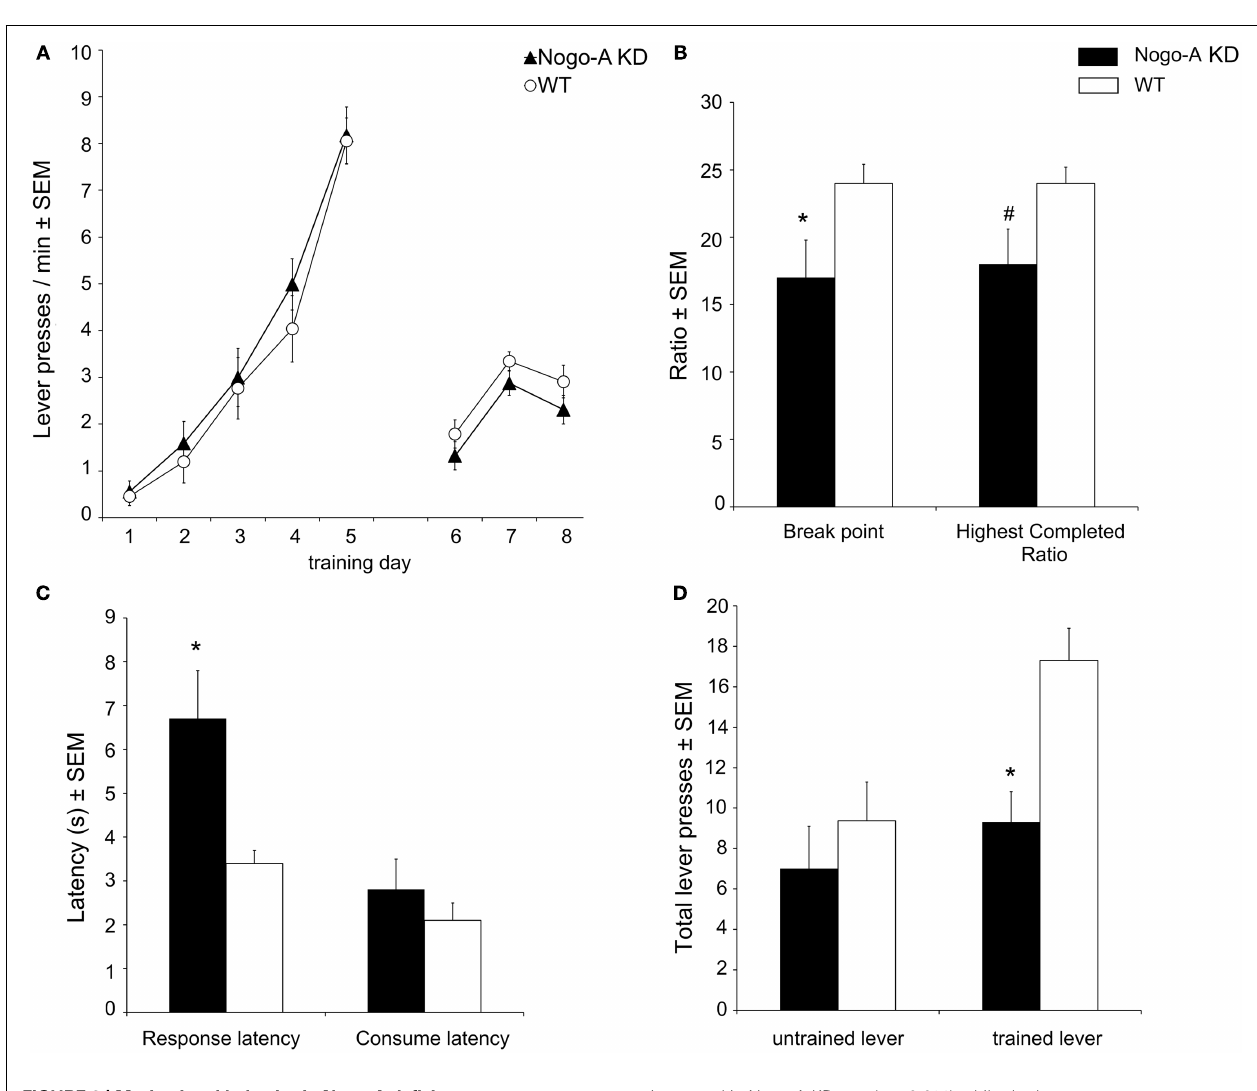
FIGURE 2 | Motivational behavior in Nogo-A deficient rats . (A) Nogo-A KD rats acquired operant responding similar toWT rats (days 1–5); additionally, there was no difference in baseline performance before the PR-Test (during days 6–8, when nose poking was required to get access to the lever). (B) In the PR-Test, Nogo-A KD rats had a significantly lower break point ( p = 0.049) and tended to have a lower “highest completed ratio” ( p = 0.088). (C) Response latency was